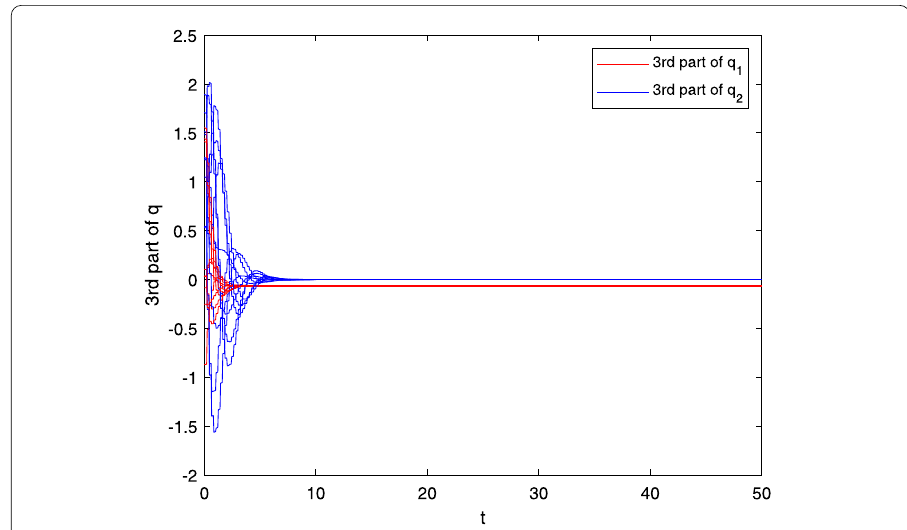
Figure 3 The third part of the state trajectories for system (1) with parameters